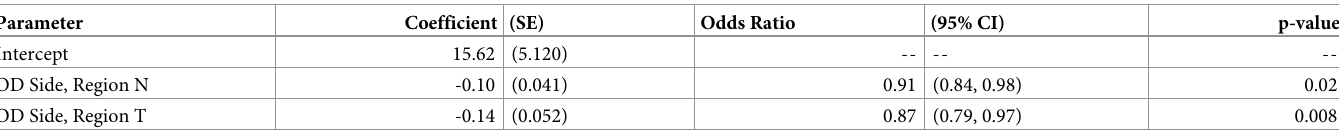
Table 2. Logistic regression model for the probability of CH-PAT based on retinal thickness in the retinal nerve fiber layer. Parameter Coefficient (SE) Odds Ratio